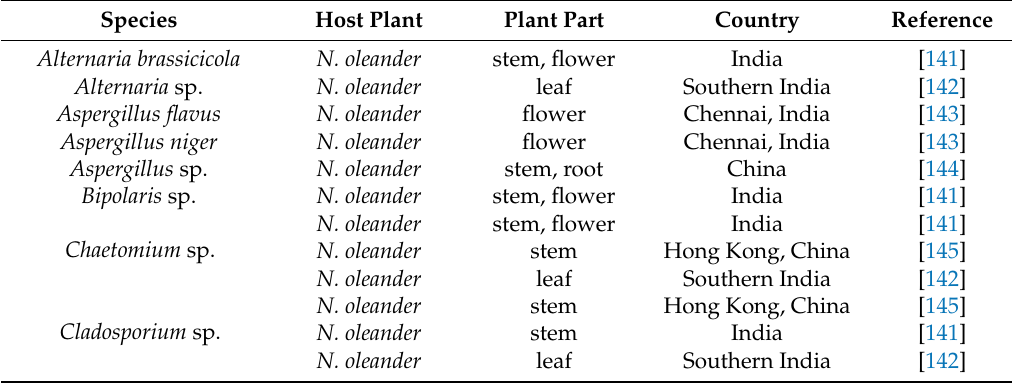
Table 13. Endophytic fungi isolated from Nerium